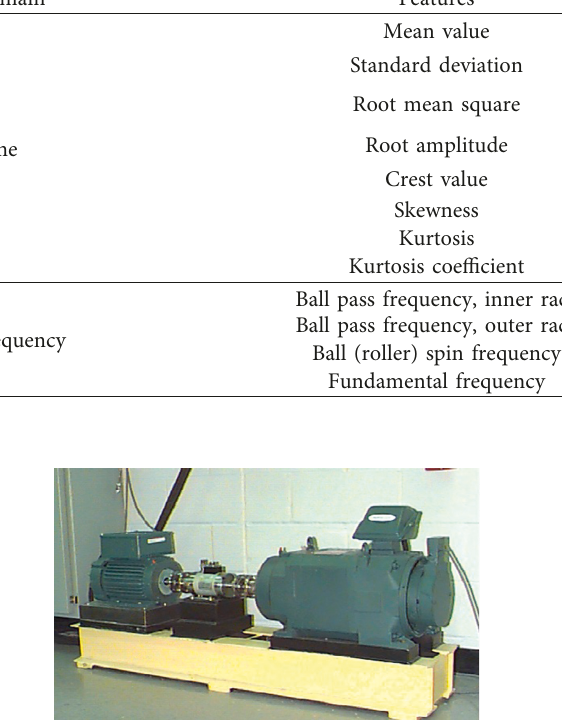
Figure 3: Experimental setup of bearing test rig in CWRU